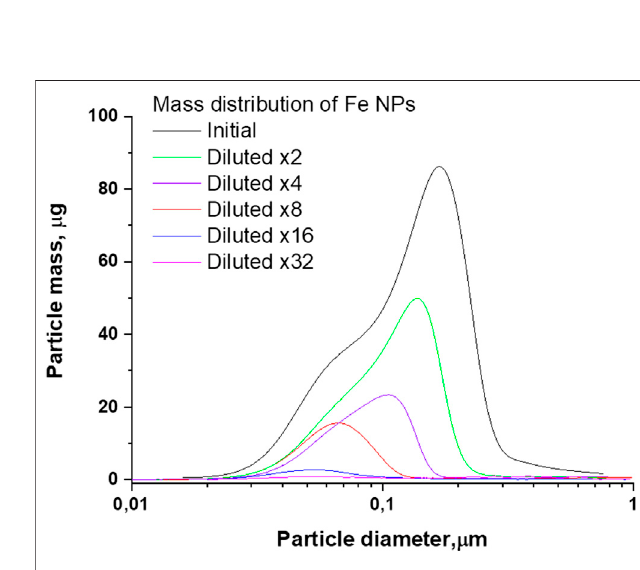
FIGURE 3 | Size distribution of Fe nanoparticles depending on the amount of dilutions of the initial colloid.